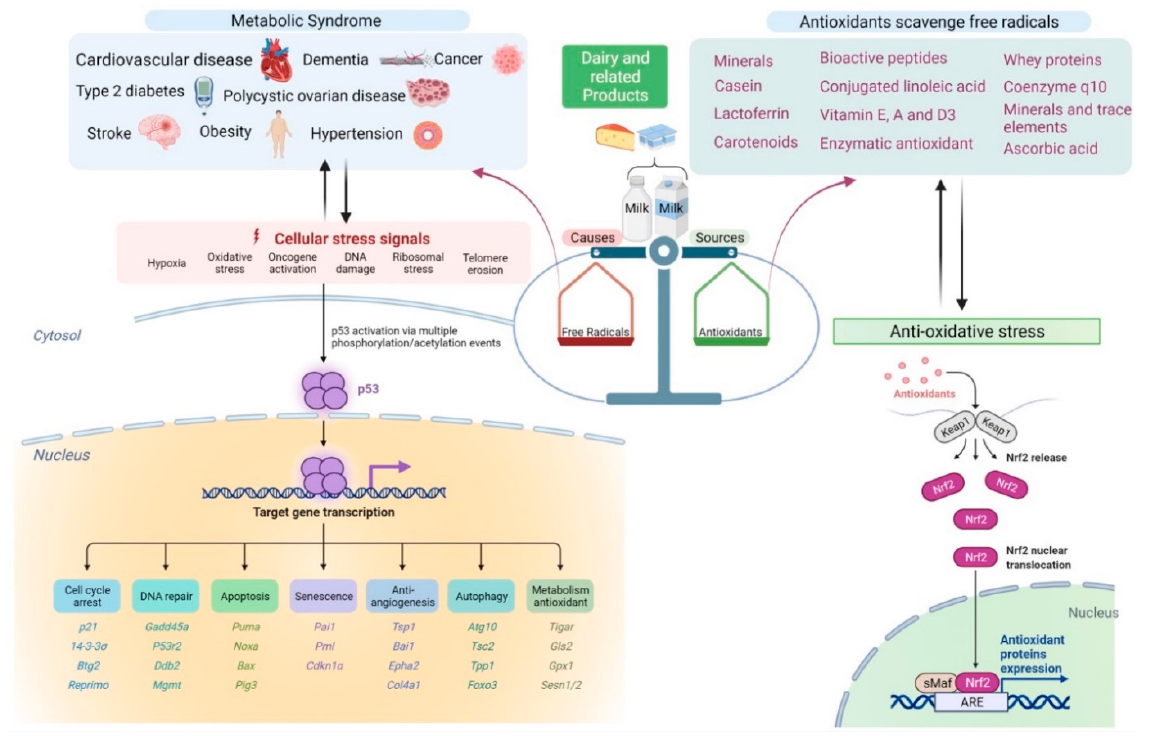
Figure 2. The illustration shows the components necessary for scavenging free radicals and supply- ing antioxidants that are present in fermented foods. These antioxidants neutralize free radicals in a number of different ways. Conceptual diagrams of the important cellular stress and anti-oxidative stress signaling pathways are